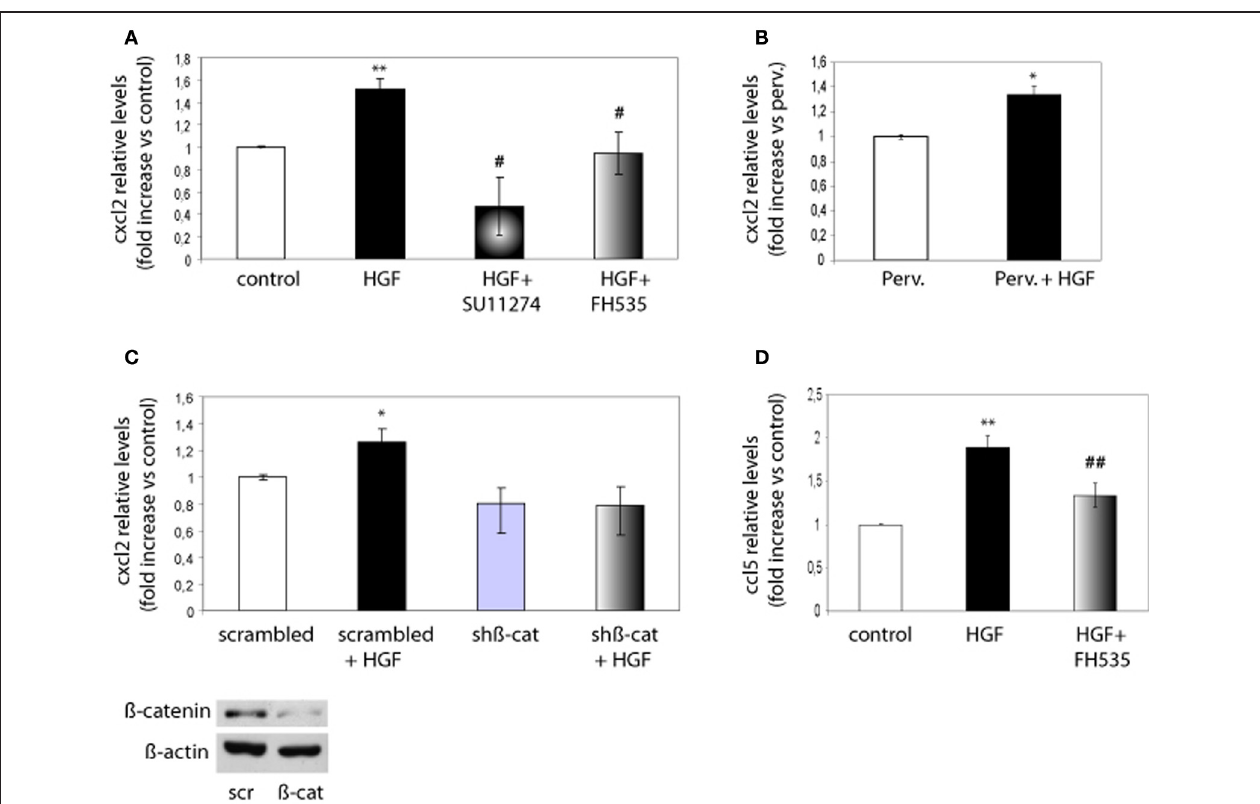
or β -catenin shRNAs, untreated or treated with HGF stimulation, indicate that HGF does not increase CXCL2 levels in neurons expressing β -catenin shRNA. Lowerpanel: Western-blot for β -catenin showsareduction in β -catenin levels in hippocampal neurons expressing scrambled (scr) or β -catenin ( β -cat) shRNAs. β -actin was used as a loading control. (D) CCL5 relative levels (4 DIV) increase by HGF and significantly decrease when neurons were co-treated with HGF and FH535. ∗ p ≤ 0 . 05, ∗∗ p ≤ 0 . 01 when comparing to control neurons. # p ≤ 0 . 05, ## p ≤ 0 . 01 when comparing to HGF-treated